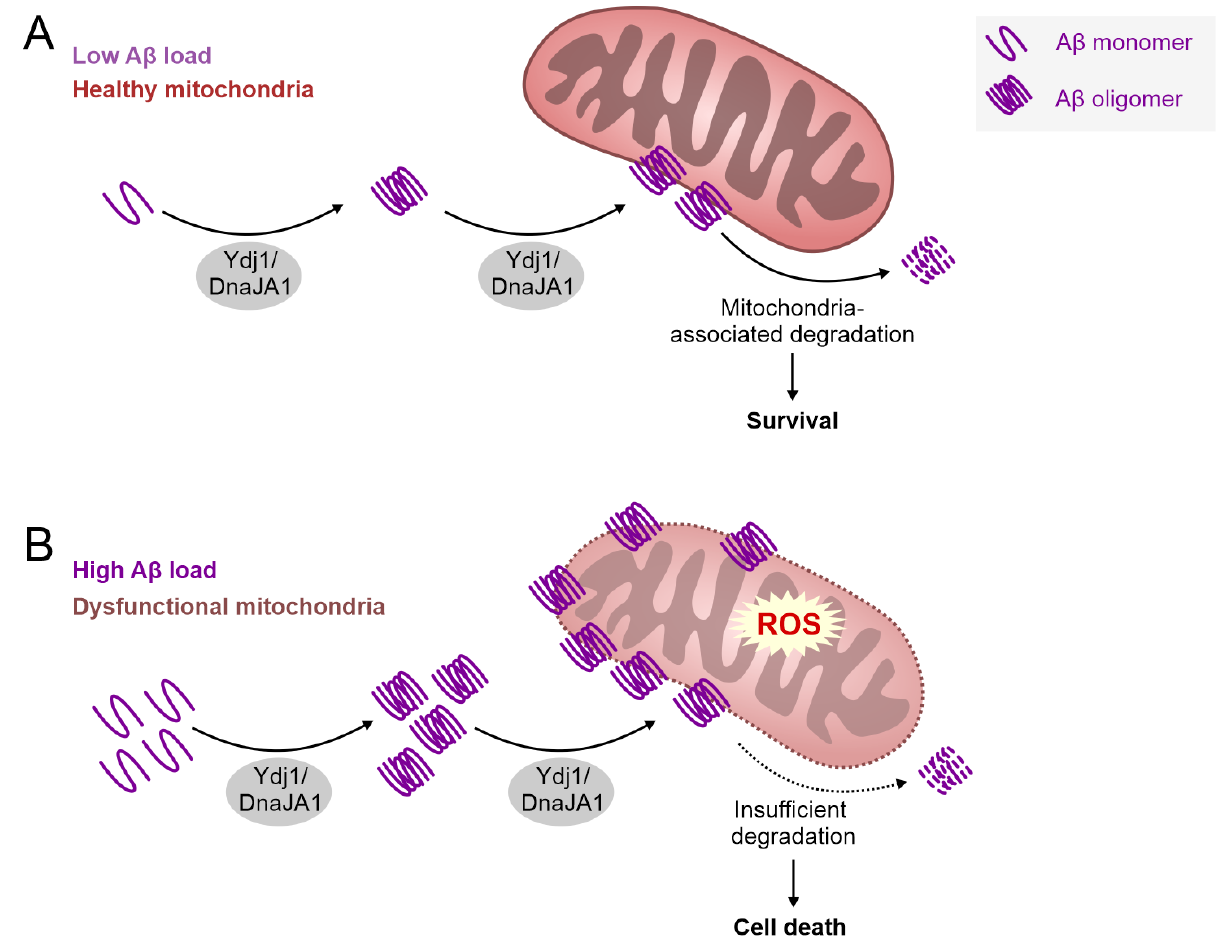
FIGURE 1: Hypothetical mechanism of Ydj1/DnaJA1 ’s role in Abeta toxicity . Abeta42 and its toxic oligomers are stabilized and translo- cated to mitochondria in a Ydj1/DnaJA1-dependent manner. We postulate that this behavior of Hsp40 family proteins is primed by the attempt to get rid of accumulating Abeta42 through mitochondria-dependent degradation ( A ). Nevertheless, in the case of high Abeta42 load or insufficient mitochondria-dependent degradation, Ydj1/DnaJA1 takes on a pathological role, leading to stressed mitochondria, eventually resulting in cell death promoting AD pathology ( B